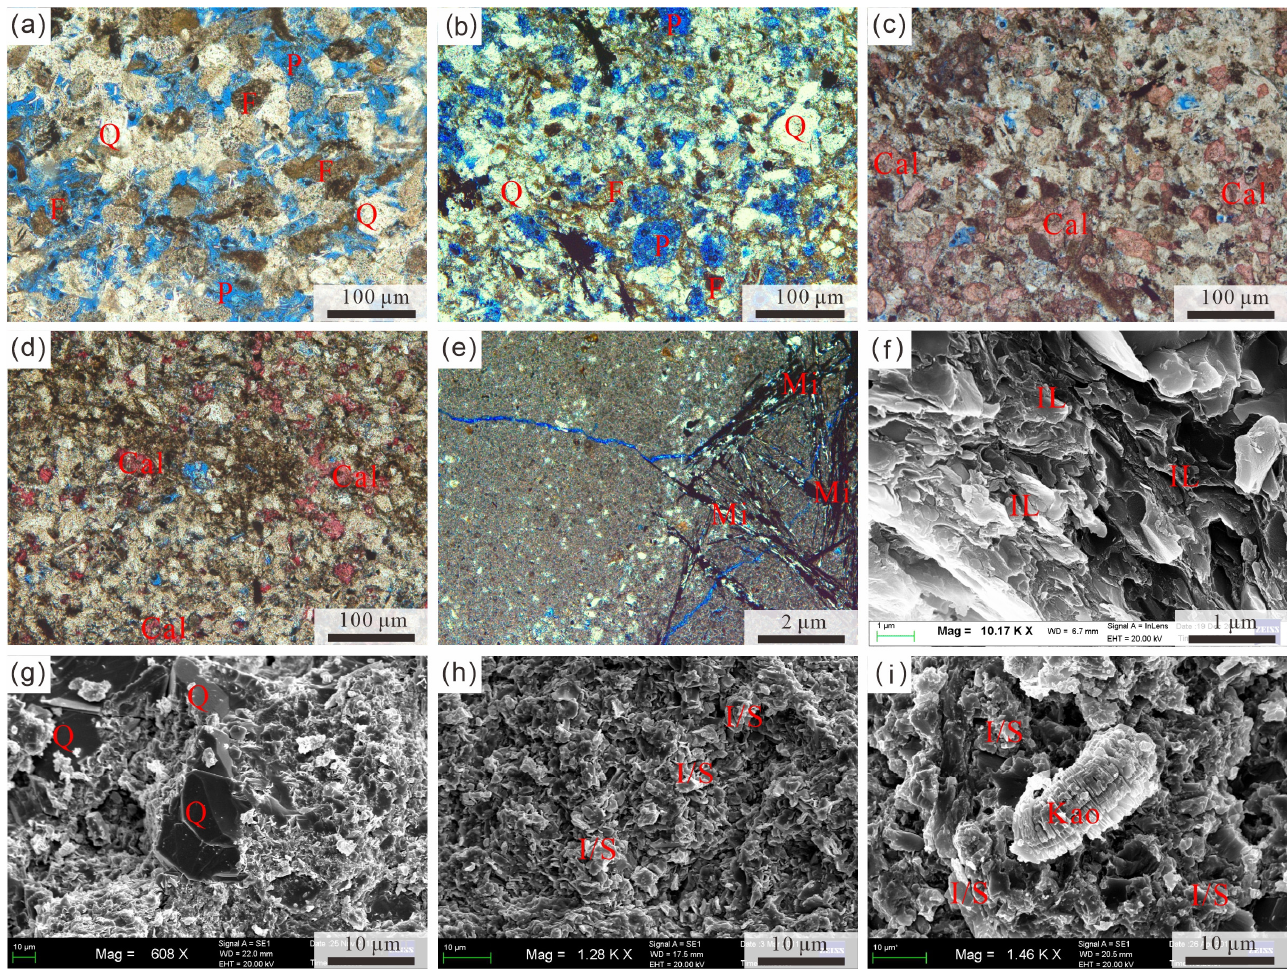
Figure 9. Different types of diagenesis in the Permian Lucaogou Formation of the Jimsar Sag. ( a ) Dissolution of fine, gray, calcareous sandstone and dissolution of feldspar grains, J31, 2725.36 m, PPL; ( b ) dissolution of tuff sludge, a tuff component dissolution phenomenon, J174, 3269.74 m, PPL; ( c ) calcite-cemented gray mudstone, J174, 3199.99 m, PPL; ( d ) gray carbonate-cemented siltstone, calcite cement, J251, 3759.40 m, PPL; ( e ) compacted, gray, calcareous siltstone. Plastic deformation of mica affected by compaction, J174, 3268.48 m, PPL; ( f ) compacted, dark gray, argillaceous dolomite. Directional arrangement of illite, J30, 4144.86 m, SEM; ( g ) fine, siliceous-cemented siltstone (argillaceous), quartz overgrowths, J172, 2927.9 m, SEM; ( h ) clay mineral cementation, dark gray dolomite mudstone, I/S distributed in the matrix, J22, 2553.92 m, SEM; ( i ) clay mineral cementation, silty-sandy mudstone, vermiform kaolinite, J25, 3412.54 m, SEM. Mi: mica; Cal: calcite cementation; I/S: mixed-layer illite/smectite; Kao: kaolinite; Q: quartz; F: feldspar; IL: illite; P: pores; PPL: plane-polarized light.